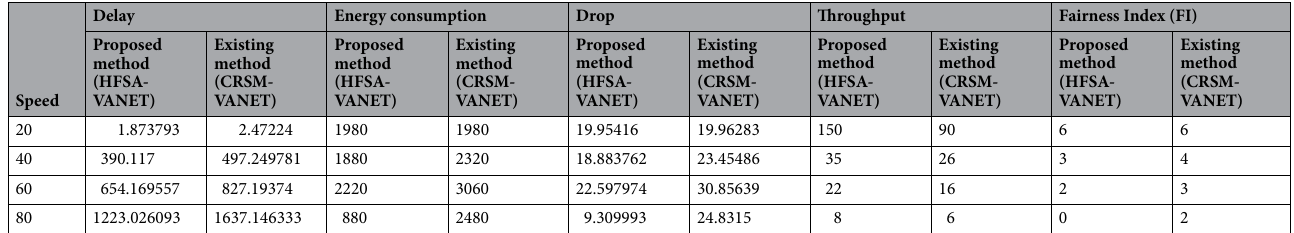
Table 2. Comparison of the proposed method to existing method of speed.